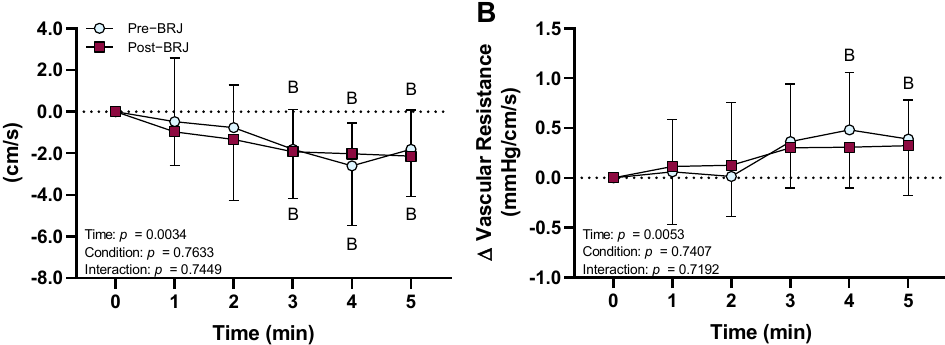
Figure 3. Effect of beetroot juice (BRJ, condition) at three hours post-consumption on blood velocity and vascular resistance in the segmental artery during CO 2 breathing (time). Data are presented as the means ± SD as the change from room air baseline (0 min). Data were analyzed using a two-way repeated-measures ANOVA with post hoc Dunnett’s tests to compare changes during CO 2 from room air baseline and post hoc Sidak’s tests to compare differences between pre- and post-beetroot juice consumption during CO 2 breathing. ( A ) segmental artery blood velocity; ( B ) segmental artery vascular resistance. n = 14 (7 females and 7 males). B different from room air baseline ( p ≤ 0.0394).